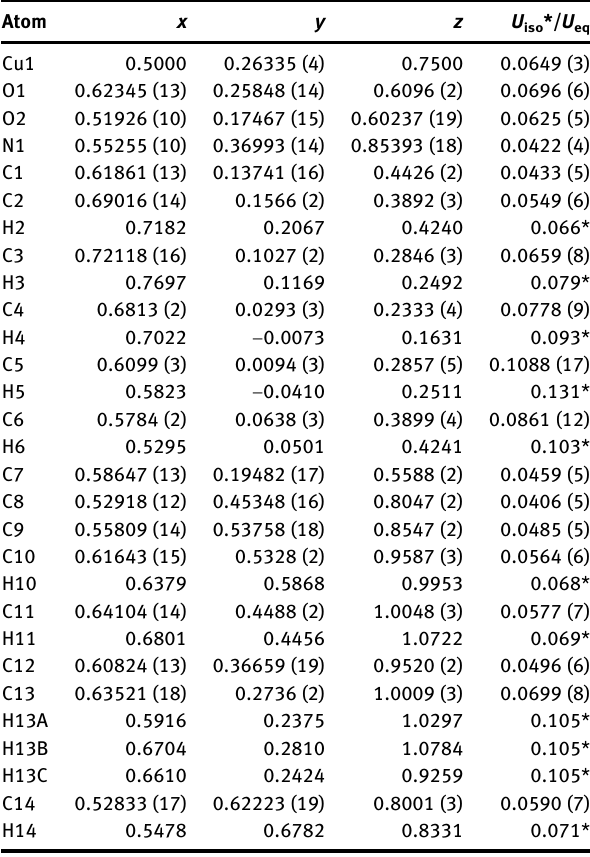
Table  : Fractional atomic coordinates and isotropic or equivalent isotropic displacement parameters (Å 